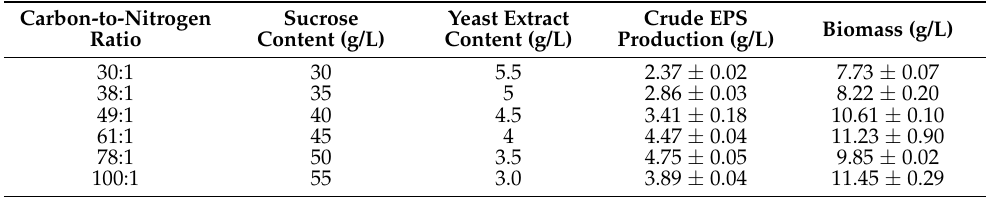
Table 1. Carbon-to-nitrogen ratio corresponding to sucrose and yeast extract content, and the yield of crude extracellular exopolysaccharide and biomass under corresponding